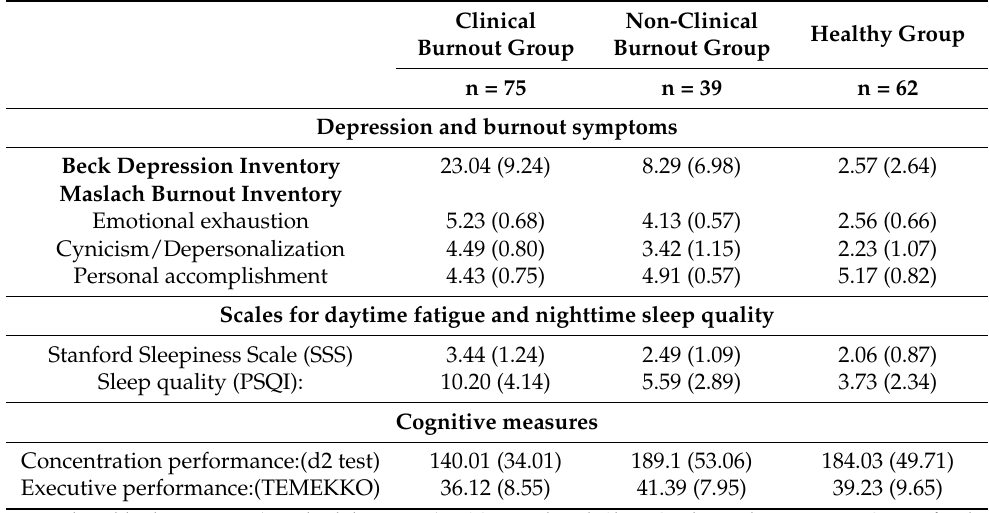
Table 2. Clinical characteristics and cognitive